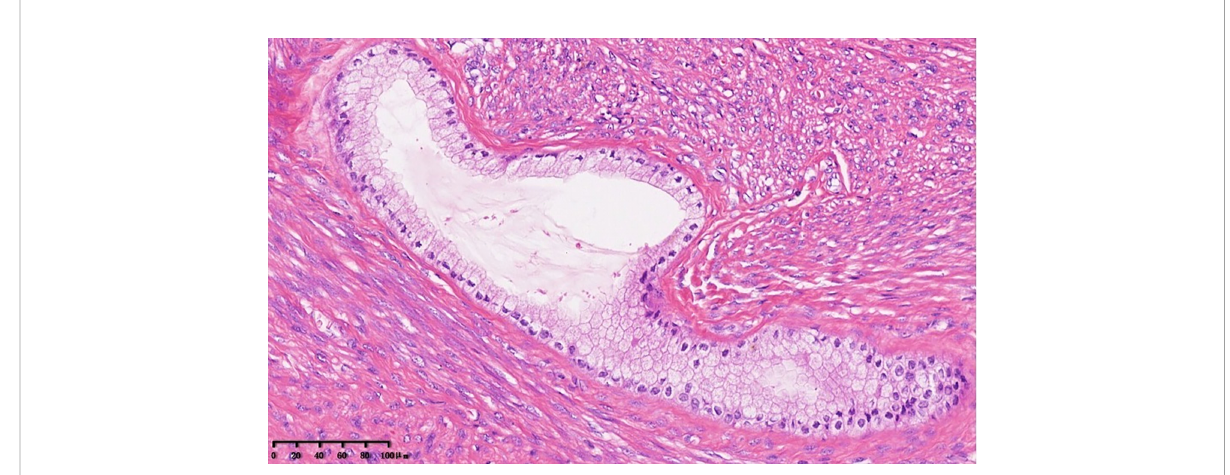
FIGURE 2 Müllerian adenosarcoma of the uterine cervix. The tumor shows benign columnar glands and low-grade endometrial stromal sarcoma of the cervix. The glands were surrounded by a cellular stroma that formed periglandular cuffs